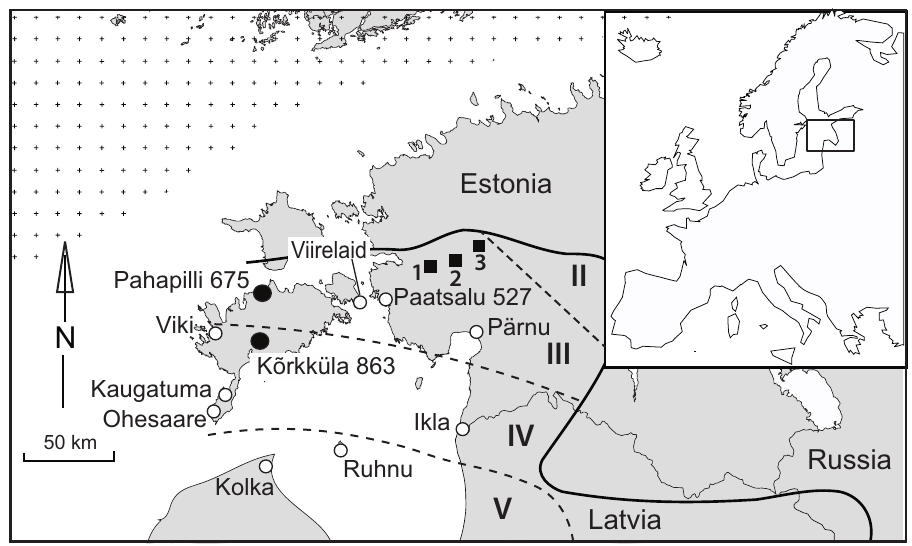
Fig. 1 . Sketch map showing the facies zones of the Adavere Regional Stage (RS) (modified from Kaljo and Rubel 1982), location of the Pahapilli 675 and Kõrkküla 863 drillings, sections mentioned in the text and outcrops with the Adavere brachiopods: Lätiküla (1), Valgu (2), Võiva at Velise (3) (Rubel 2011). Legend: outer limit of the Adavere RS (solid line), boundaries between facies zones (dashed line) (according to Kaljo and Rubel 1982; Nestor and Rubel 1997) – shoals (II) and open shelf (III), transitional facies to deeper basin (IV), deep basin